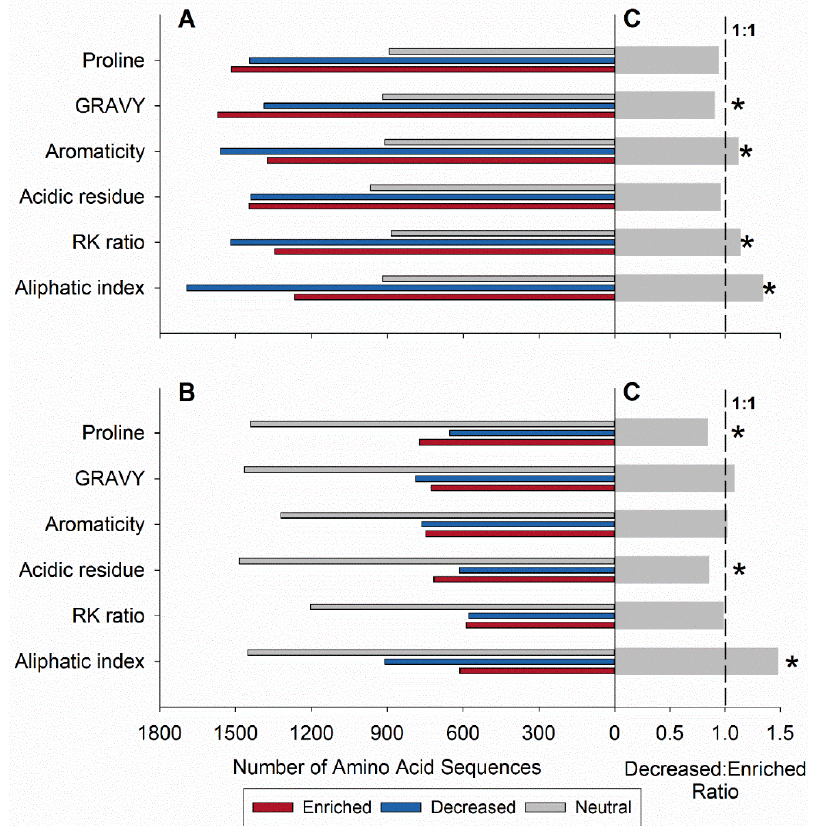
Figure 5. Genome-wide molecular cold-adaptation in CG23_2 compared to ( A ) 31 Janthinobacterium spp. isolated from mesophilic environments and ( B ) four Janthinobacterium spp. found in polar / glacial regions. ( C ) Adaptation ratios (decreased: enriched) with significant indices are indicated with an asterisk (Bonferroni-corrected p ≤ 0.005). Decrease indicates cold adaptation. GRAVY: grand average of hydropathicity; R/K: arginine/lysine.